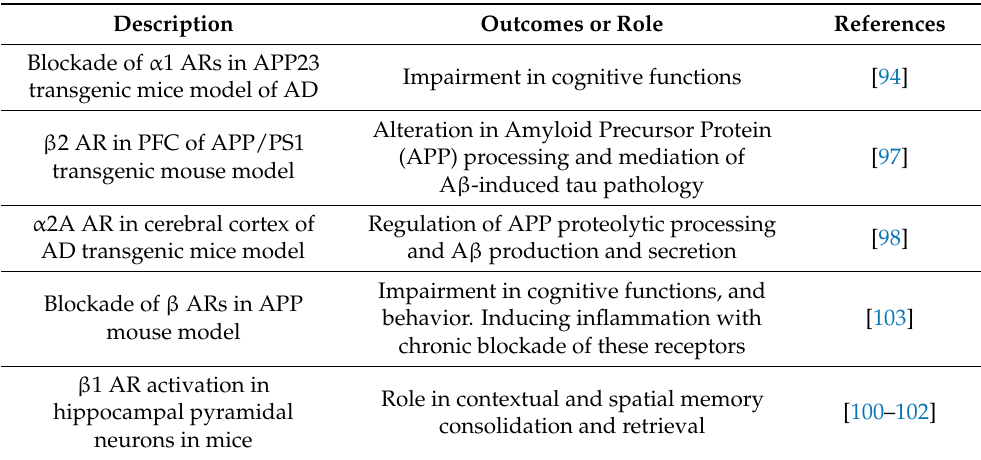
Table 2. Role of adrenergic receptors in the brain. The role of adrenergic receptors such as α or β adrenergic receptors (ARs) in different brain regions of Alzheimer’s disease (AD) mice models is summarized.